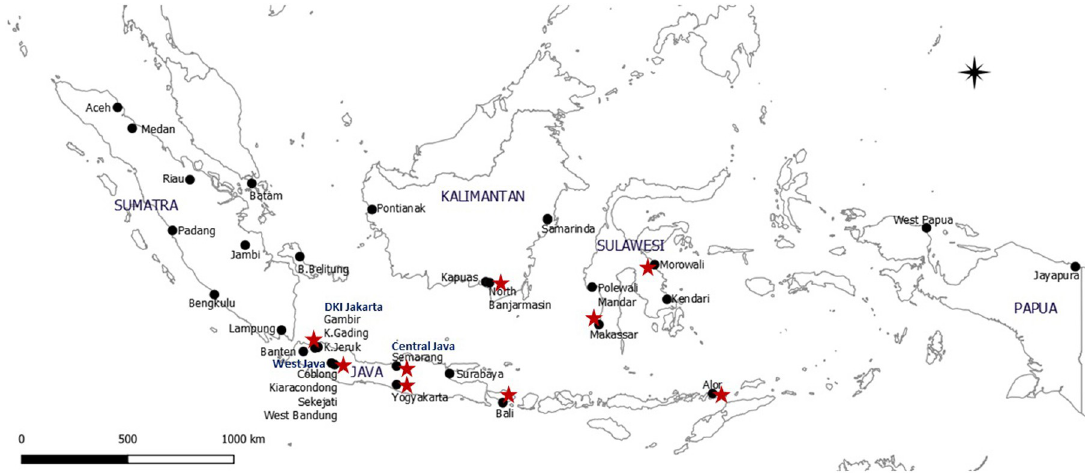
Fig 1. Map of Ae . aegypti collection sites in Indonesia (32 strains). Map base layer was obtained from https://www.naturalearthdata. com/. Map base layer was modified in QGIS software version 3.4 Madeira. Note: $ indicates sites where pyrethroid-resistant Ae . aegypti mosquitoes were previously